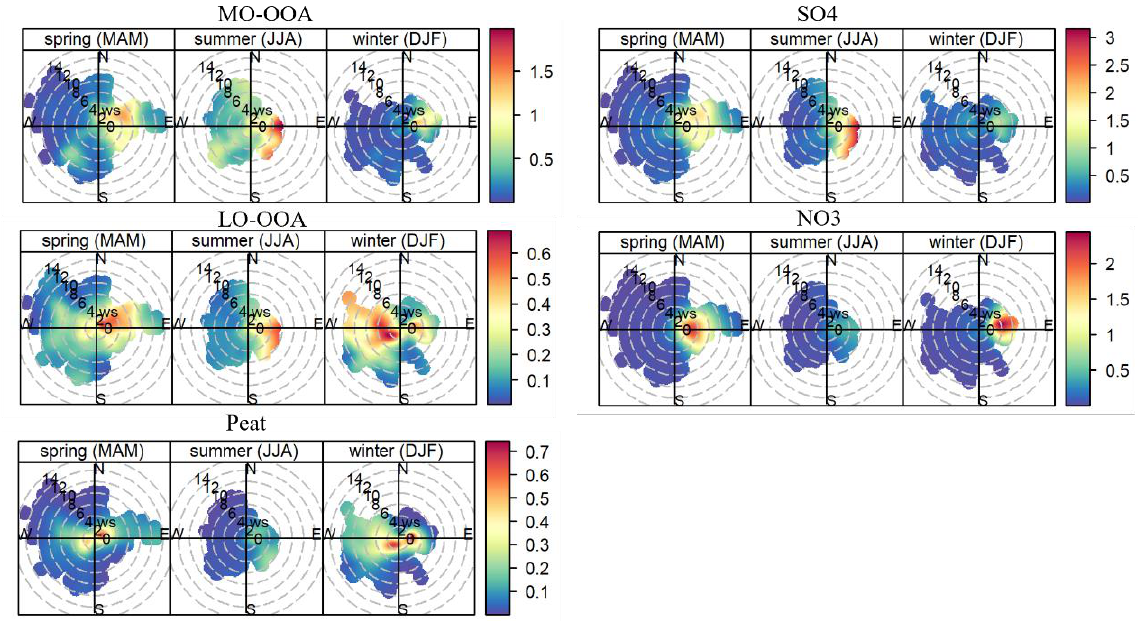
Figure 8. Polar plot of hourly averaged MO-OOA, LO-OOA, peat (for the rolling PMF), SO 4 , and NO 3 as a function of wind speed (radial axis, m s − 1 ) and wind direction during spring, summer, and winter, color-coded by respective concentrations ( µ g m − 3 ). The polar plots were plotted using openair package with R software (version 4.1.2)